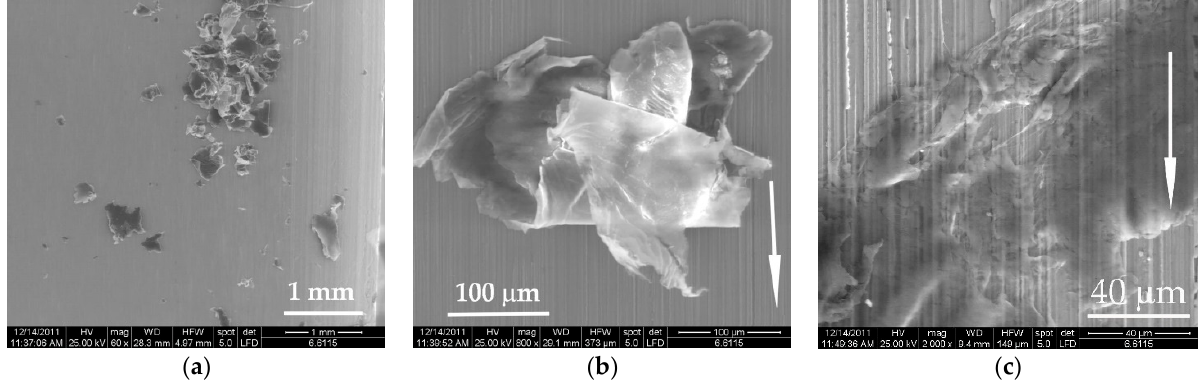
Figure 14. Transfer on the metallic disk from tests done in dry regime, on a block-on-ring tester, PTFE, tested under 5 N, v = 0.75 m/s, L = 7500: ( a ) lumpy, refragmentated wear deposit on the steel ring; ( b ) rolled and pressed wear particle from the PTFE block; ( c ) microzone with better adhered PTFE.